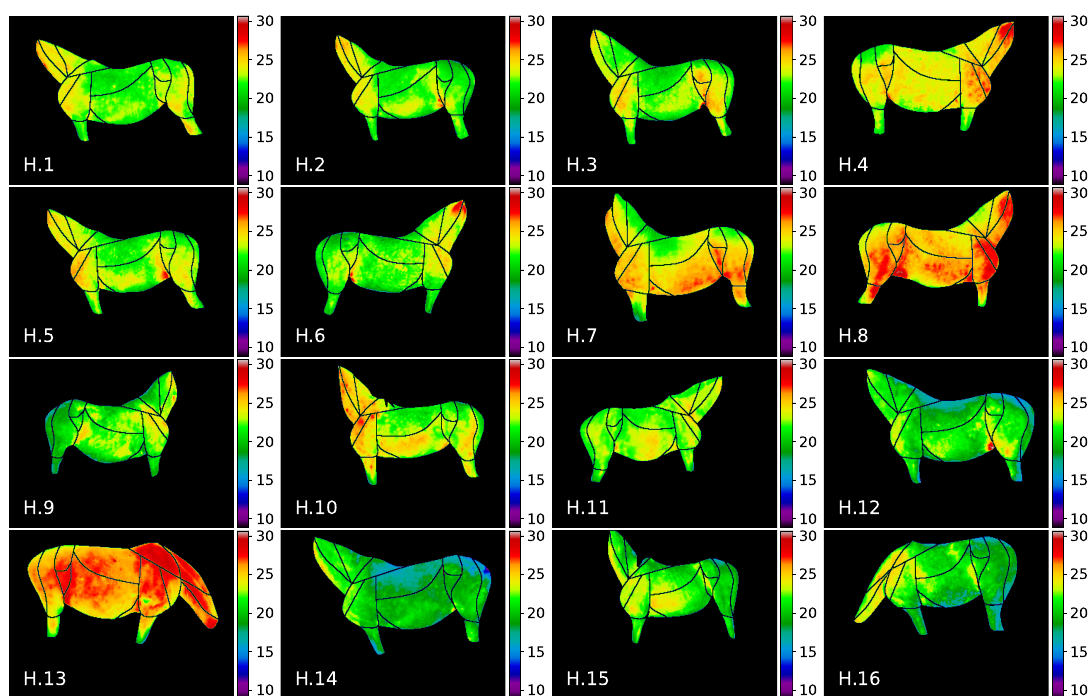
Figure 7. Thermal maps of annotated ROIs for horses in our dataset.